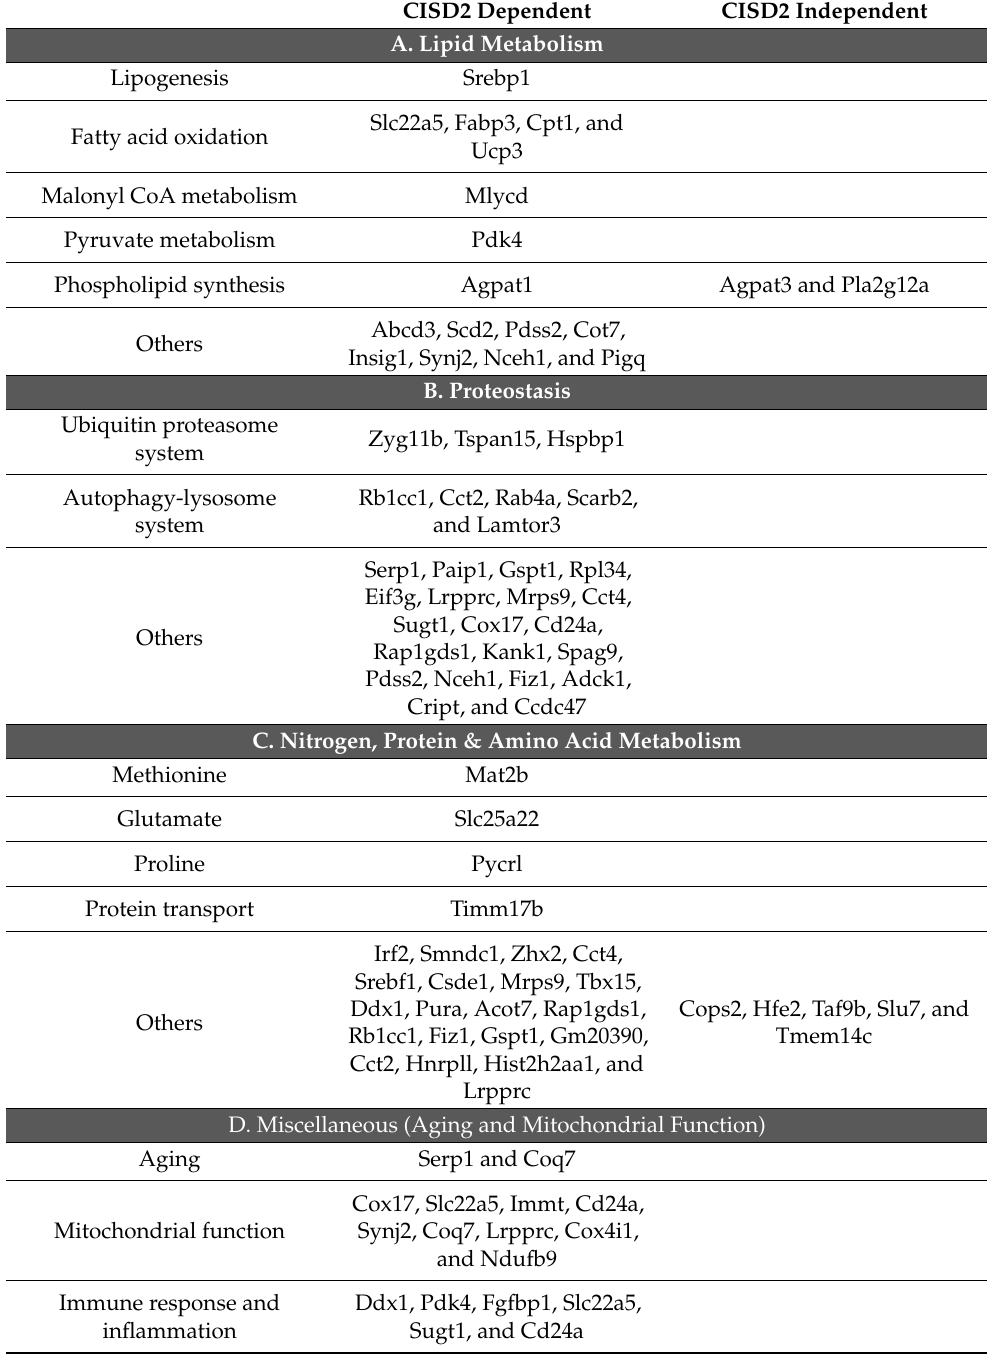
Table 2. DEGs influenced by hesperetin through CISD2-dependent or CISD2-independent pathways. CISD2